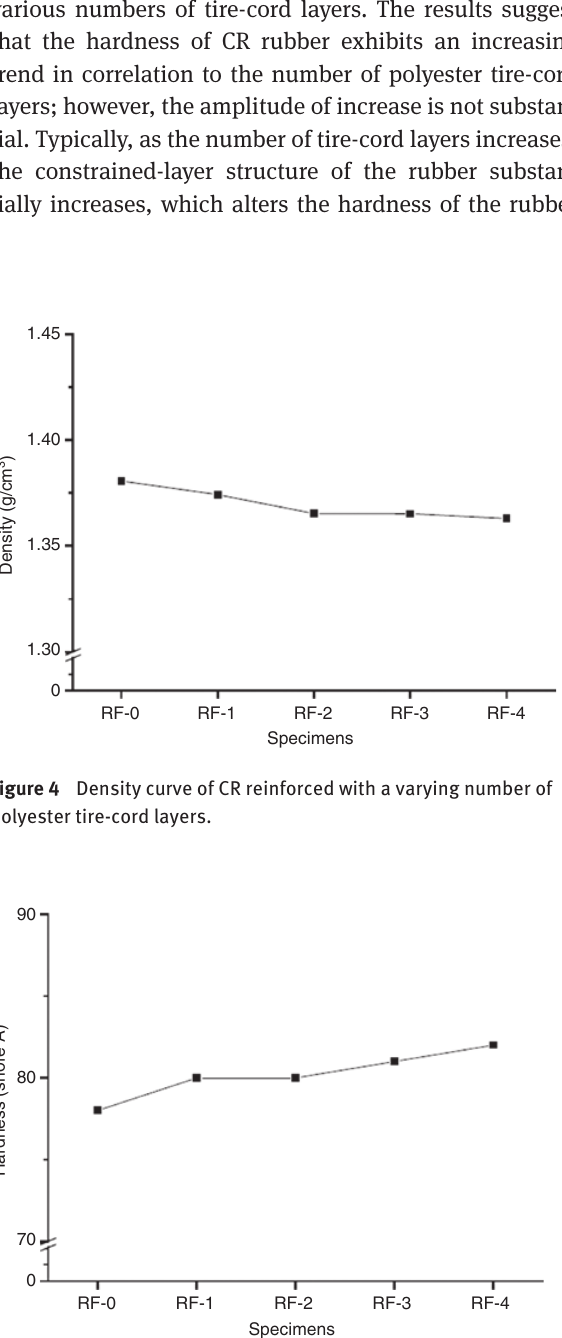
Figure 5 Hardness of CR reinforced with a varying number of polyester tire-cord layers.